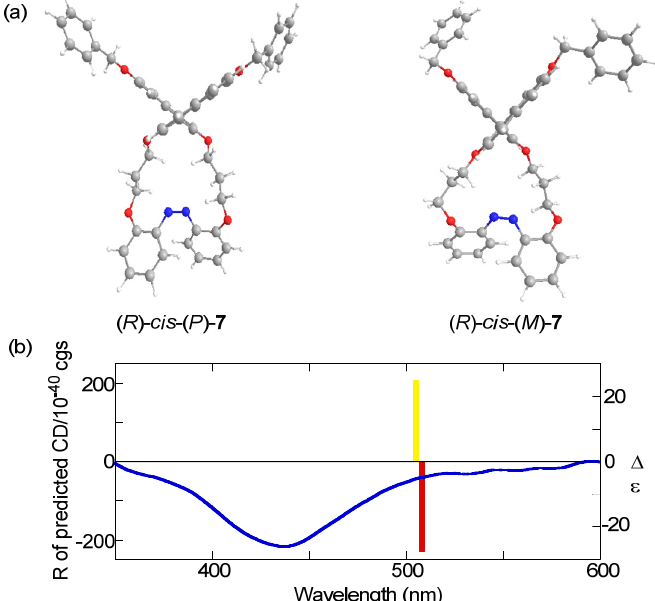
Figure 12. (a) Optimized structures of ( R )- cis -( P )- 7 and ( R )- cis -( M )- 7 obtained by the DFT calculations at the B3LYP/6-31G(d) level. (b) CD calculated by the TD-DFT method with the B3LYP/6-31G(d) level of ( R )- cis -( P )- 7 (red bar), ( R )- cis -( M )- 7 (yellow bar), and experimental CD of ( R )- 7 after 365-nm irradiation (blue line, 1 × 10 − 5 M in 1,4-dioxane, 20 °